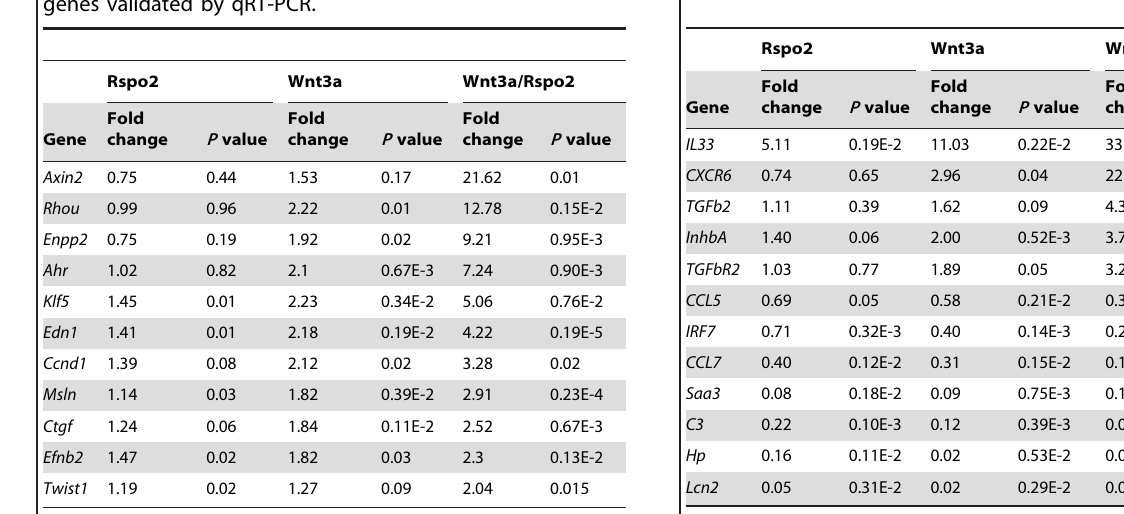
Table 2. Microarray data of immune response genes validated by qRT-PCR.